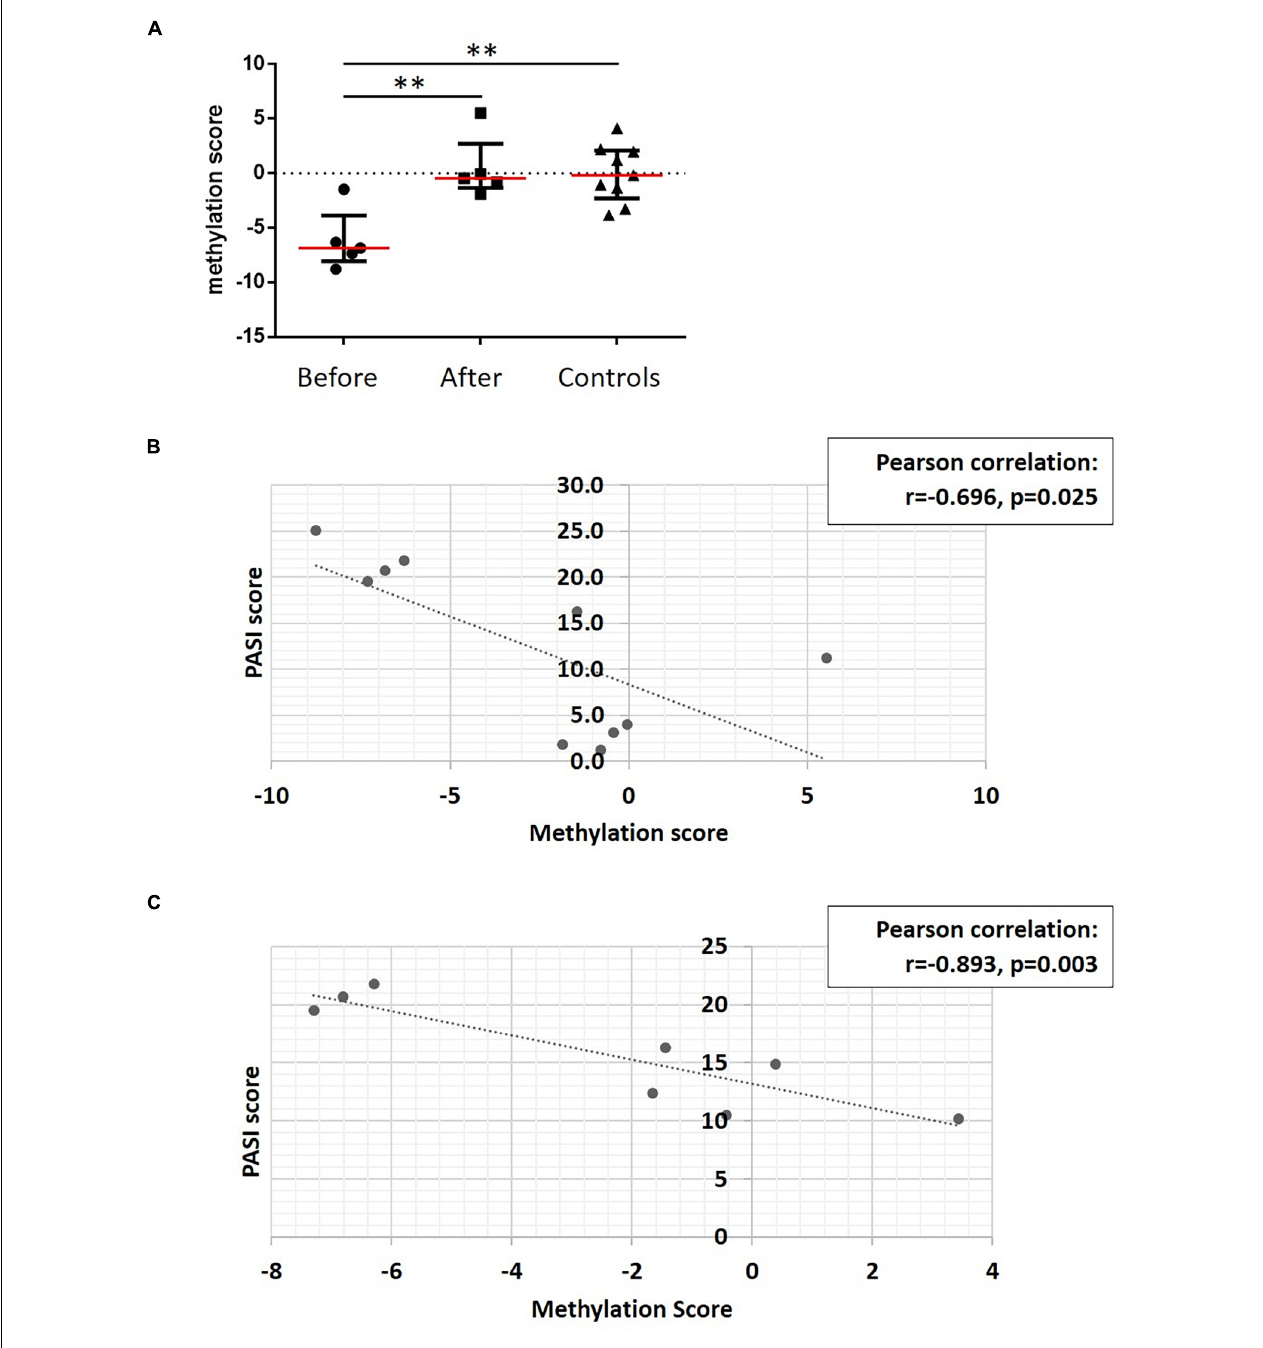
FIGURE 6 | A DNA methylation score associates with disease activity. (A) DNA methylation scores were calculated in patients before treatment, and after treatment and healthy control. ** p ≤ 0.01, Dunn’s multiple comparisons test. Median (red) and interquartile range are represented in this scatter plot. (B) Correlation analysis between methylation scores and PASI scores in patient cohort before and after treatment. After assessing Gaussian distribution, Pearson was used to measure the correlation. (C) Correlation analysis between methylation scores and PASI scores in the psoriasis patient cohort. After assessing Gaussian distribution, Pearson was used to measure the correlation. Dotted lines indicate a